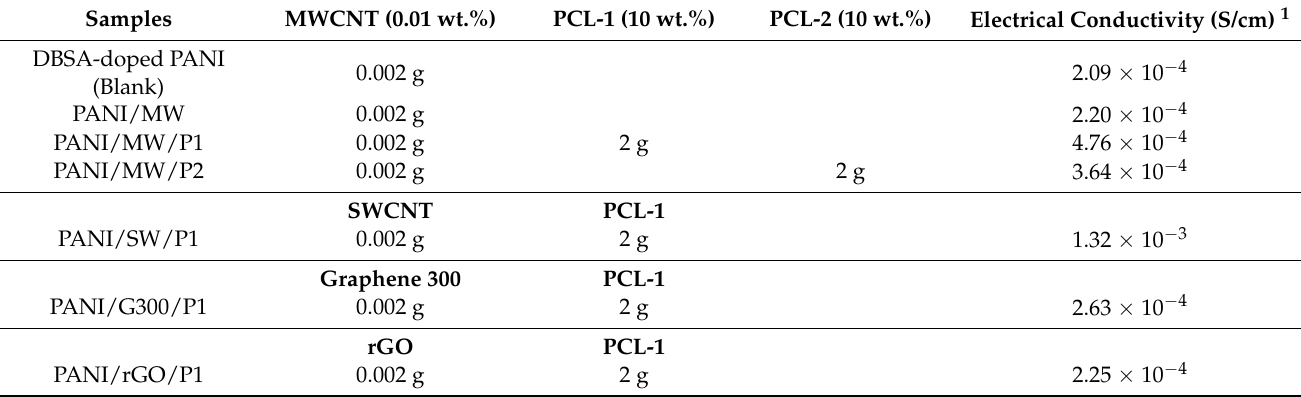
Table 1. Preparation of different nanocomposites and their electrical conductivity.